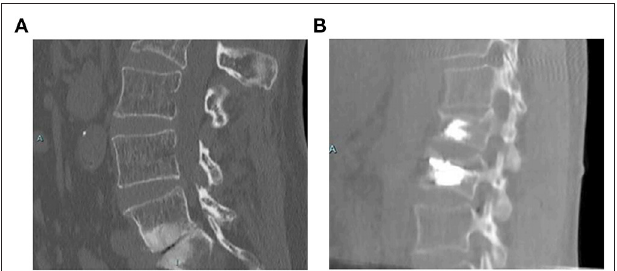
FIGURE 3 | Treatment with PKP (47). A 58-year-old female with a non-specified mitochondrial pathology and a history of L1 vertebral fracture treated with kyphoplasty. She presented with pain in the lumbar region after a fall. She was treated with PKP, and demonstrated an unremarkable postoperative course. (A) Computed tomography scan showing a L2 fracture with a deformity in both the sagittal and coronal planes. (B) Postoperative scan showing correction in both the sagittal and coronal planes. PKP, percutaneous balloon